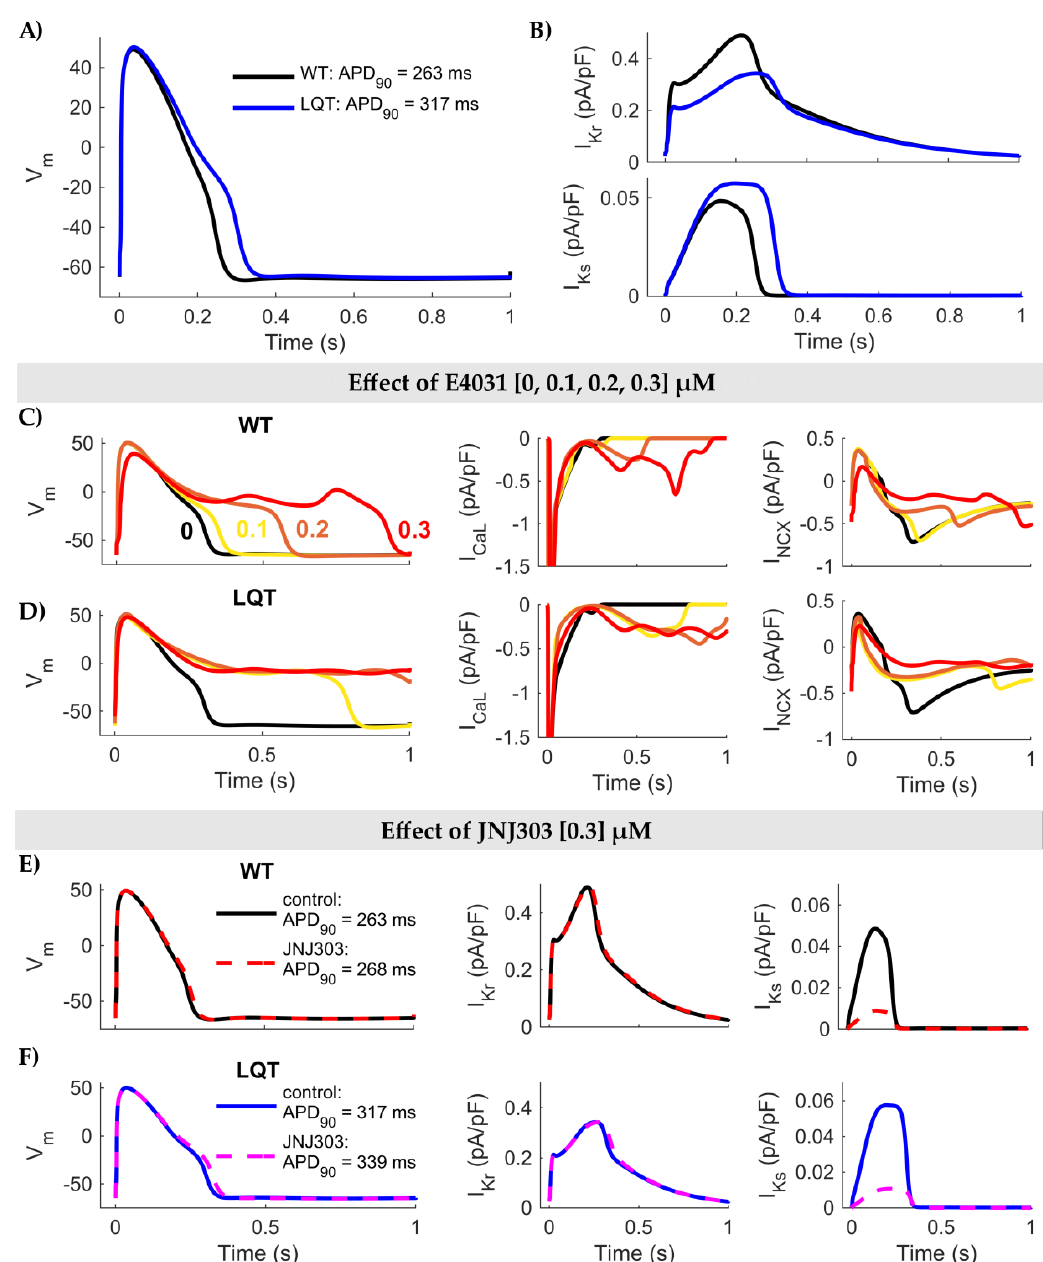
Fig 6 Figure 6. Drug responses of healthy controls vs. LQT2 hiPSC-CMs in-silico. ( A ) Comparison of AP from the healthy control hiPSC (black) and the LQT2 (blue) showing a prolongation of 20.53% in APD90. ( B ) E ff ect of p.L552S HERG mutation on the densities of K + currents, with a reduction in IKr, but an increase in IKs. ( C , D ) E ff ect of the IKr blocker E4031 at 0 µ M (black), 0.1 µ M (yellow), 0.2 µ M (orange) and 0.3 µ M (red) on AP morphology (left panel), in healthy control hiPSC and LQT2, and the e ff ect of the IKr block 0%–100% on the L-type calcium channel (middle panel) and the sodium channel exchanger NCX current (Sodium calcium exchanger- calcium e ffl ux current) (right). ( E , F ) E ff ect of the IKs blocker JNJ303 on the control (top) and the LQT2 (bottom) with baseline as (solid line) 0.3 µ M JNJ303 (dotted line) on the AP morphology. Finally, the e ff ect of the IKs block 0%–100% on the densities of IKr and IKs, shown using black solid and red dotted lines for the controls and blue solid and pink dotted lines for the LQT2,